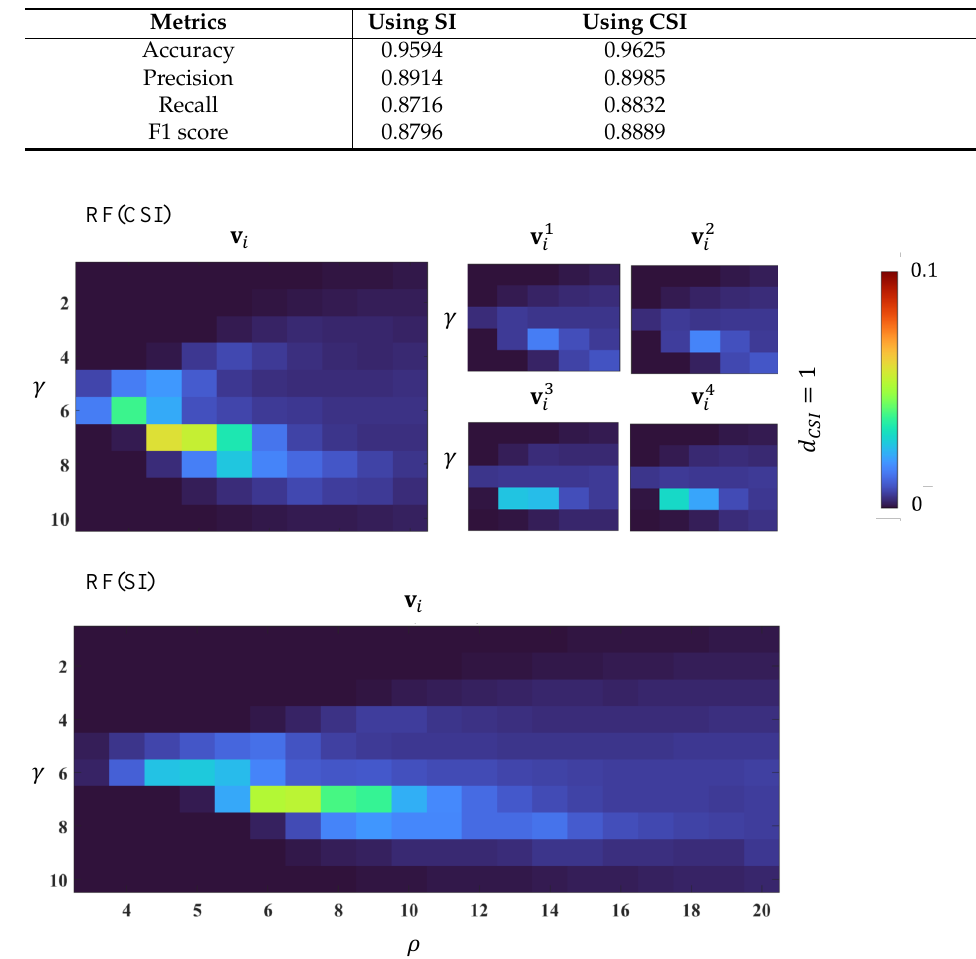
Figure 12. Comparison of feature importance of RF(CSI) and